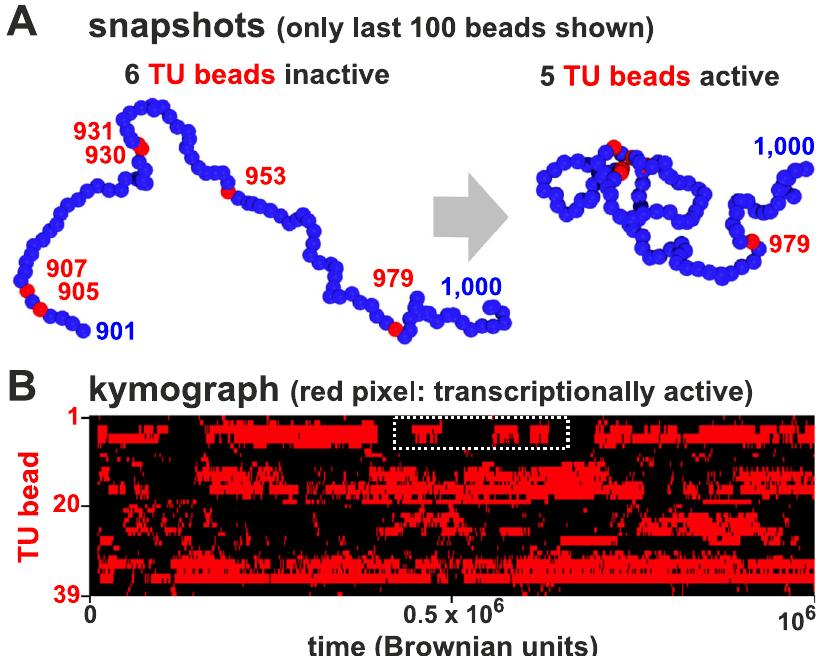
Fig. 2 Transcriptional bursting. A Snapshots showing a 100-bead section of the simulated chain taken at different times. Initially, none of the 5 TUs (red) are in clusters and they are all inactive; later, 4 TUs join a cluster and are close to TFs — and so are transcribed. B Kymograph where each row shows the changing transcription state of one TU during a simulation; pixels are colored red if the bead is associated with a TF and so transcribed, or black otherwise. White rectangle: example of While Fig. 1C pertains to population averages of 1000 simula- tions, it is informative to consider each simulation independently (as in single-cell transcriptomics). Such analysis shows that transcriptional activity is stochastic, varying substantially from simulation to simulation: a TU active in some simulations may be silent in others (Fig. 1D).